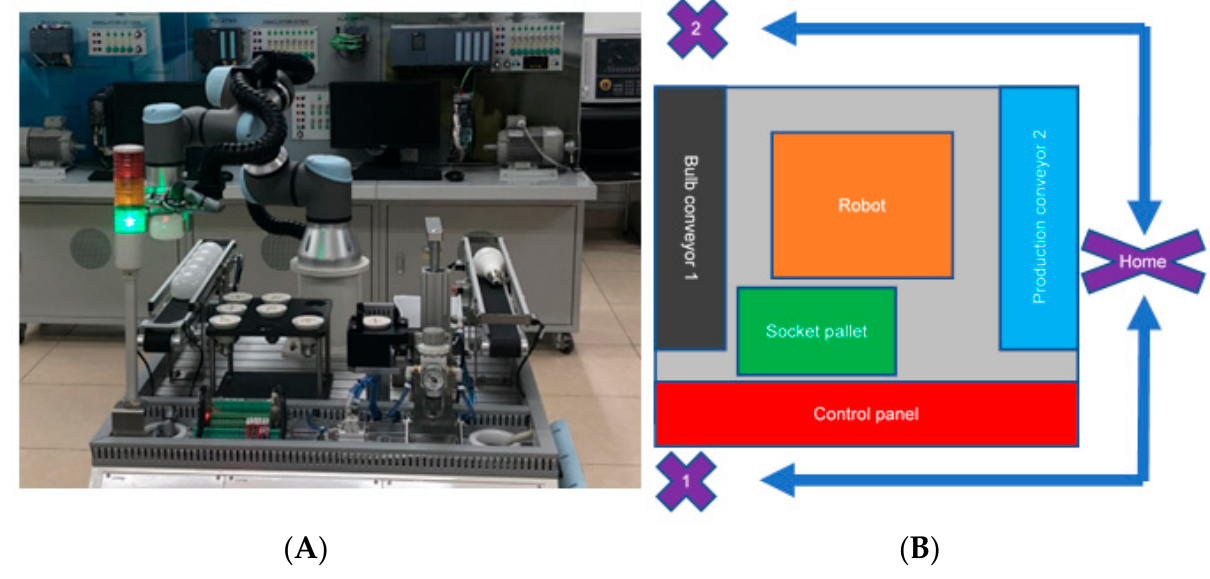
Figure 1. Real picture ( A ) and diagram ( B ) of miniature lamp assembly system.